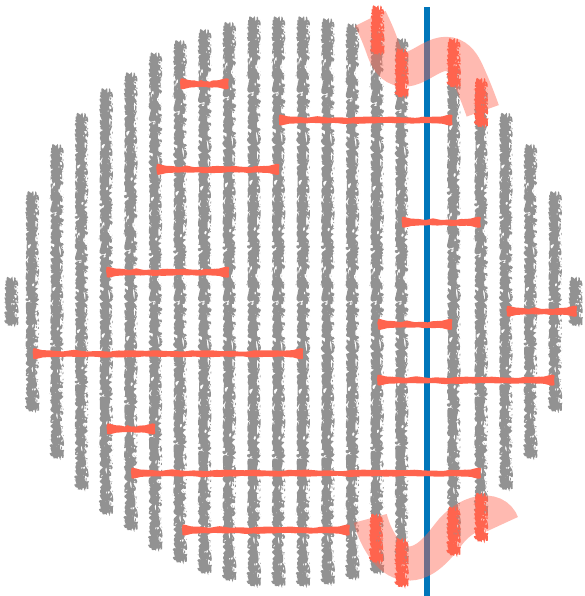
Figure 1 . The eigenvalues of the X matrix are distributed in a circle and delocalized in the vertical direction. These are shown as fuzzy gray lines in the figure. The vertical entanglement cut through the droplet is shown with a solid blue line. Several illustrative off-diagonal modes connecting pairs of eigenvalues are shown with horizontal red lines. If these cross the entanglement cut they will contribute to the entanglement. The collective dynamics of the eigenvalues themselves is incompressible and described by a boundary mode. Fluctuations of this boundary mode close to the cut, shown in red in the figure, also contribute to the